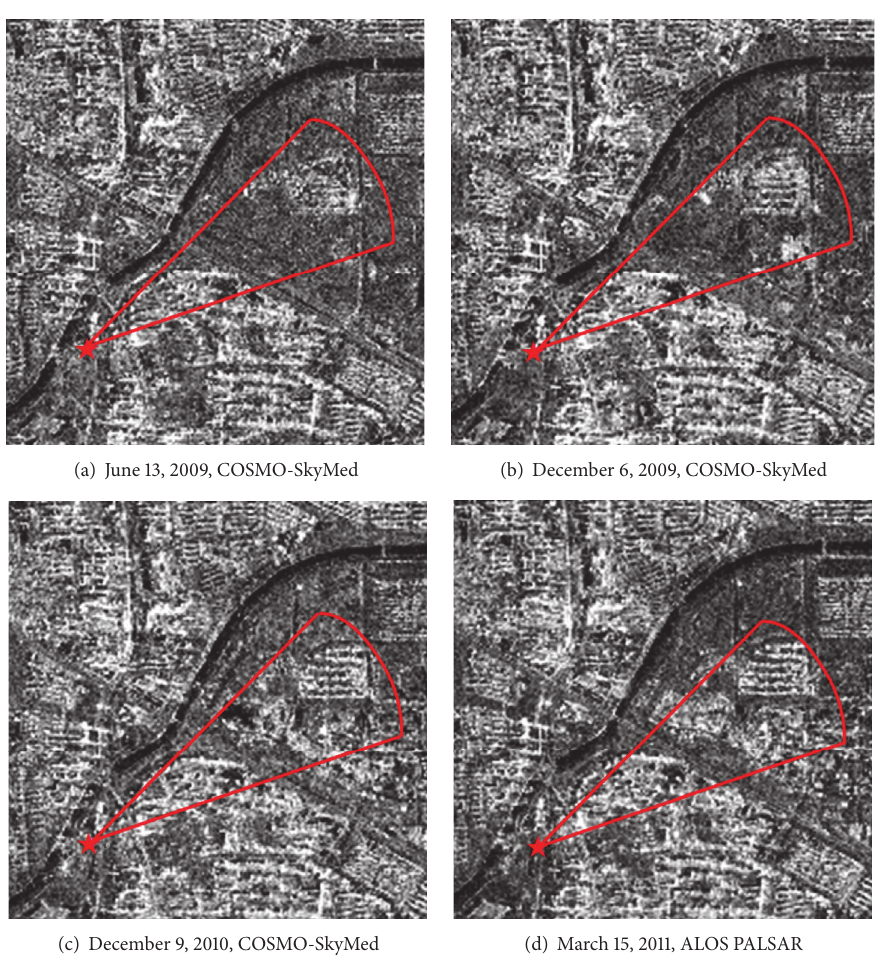
Figure 13: Multitemporal SAR images of the test area. The red star indicates the position of 𝑧 0 calculation and the red lines indicate the upwind sector is in the 60 ∘ direction (from the 45 ∘ to 75 ∘ direction, the radius of 2500